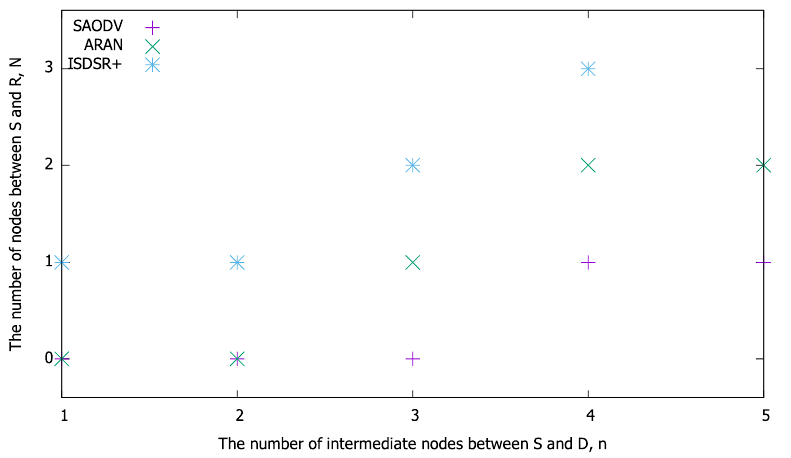
Figure 4. Threshold of N for n , showing that the proposed method is superior to the existing method in terms of the total